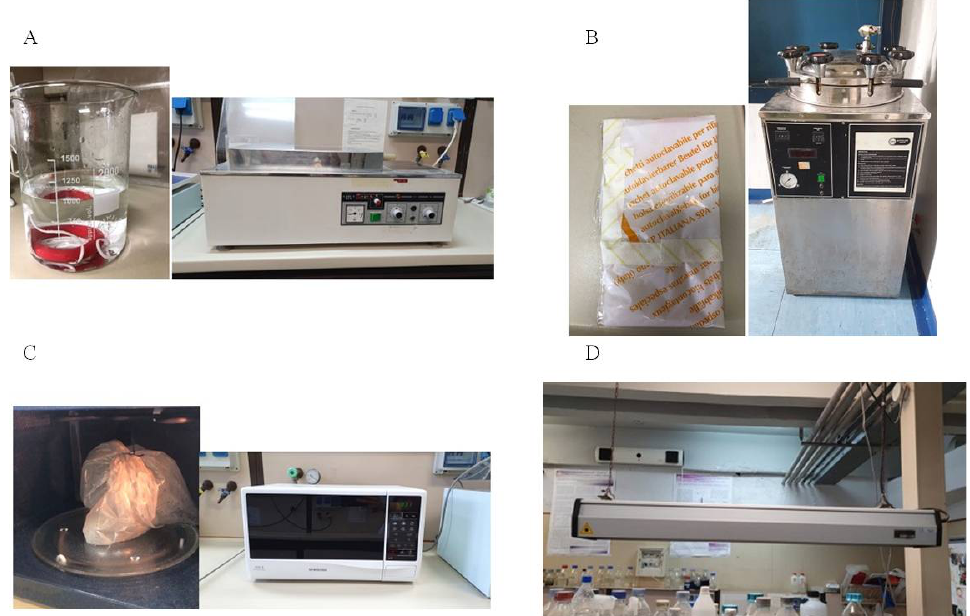
Figure 1. Pictures of the equipment used for the decontamination methods: immersion in hot water ( A ); exposure to autoclave steam ( B ); microwave-assisted sterilization ( C ); exposure to UVGI ( D ).